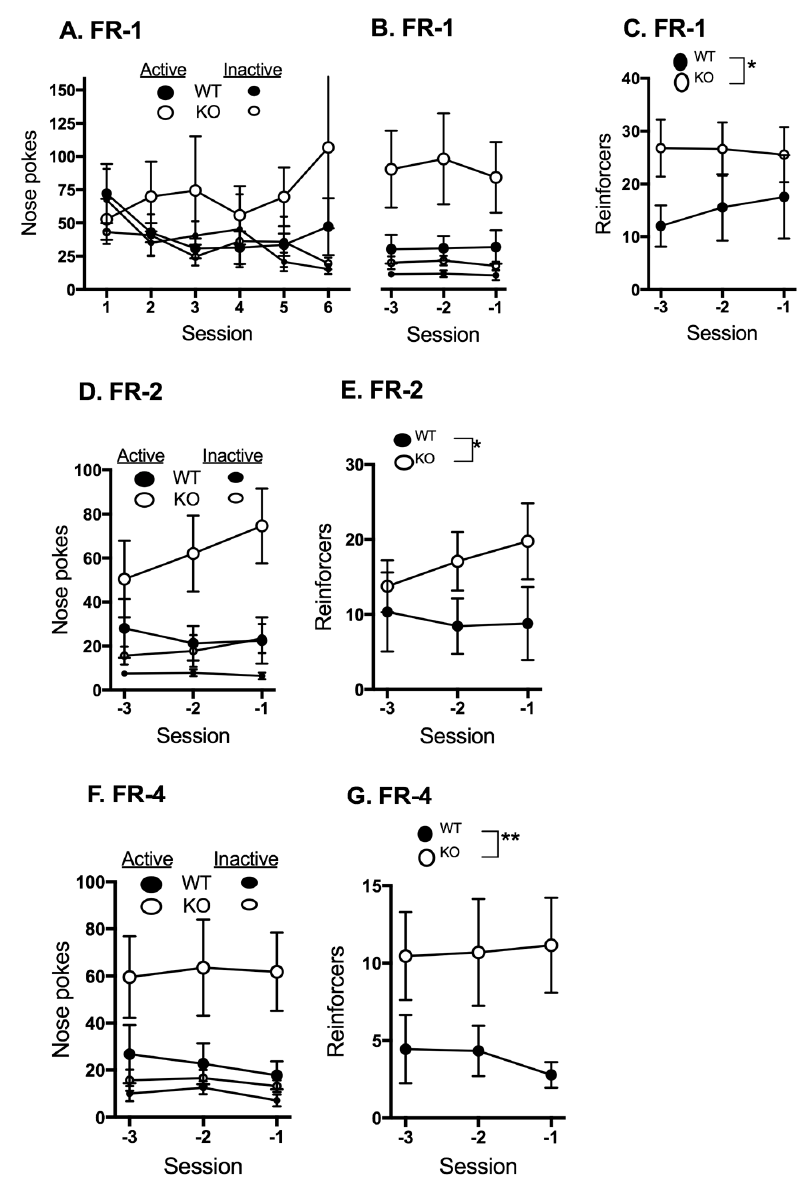
Figure 4. Comparison of WT and fatty acid amide hydrolase knock out (FAAHKO) active and inactive nose-poke responses and reinforcers earned during FR schedules. Mice (9 WT and 13 FAAHKO) were placed into operant chambers with two nose-poke ports for 2 h daily for 6 consecutive days per week. Responses in one of the nose-poke ports triggered a combination of visual and auditory responses, the other did not. Mice progressed through three FR schedules in sequence. Responses in the active port are indicated with large circles, inactive with small circles. Filled circles represent data from WT mice, open circles from FAAHKO mice. Mean values are shown; vertical lines represent SEM. Negative numbers in panels B–G denote the final three sessions prior to the session in which criteria were met for promotion of each animal to the next schedule. ( A ) Mean nose-poke responses in the active and inactive ports during the first six sessions of FR-1; ( B ) Mean nose-poke responses in the active and inactive ports during the final three sessions of FR-1; ( C ) Mean reinforcers earned during the final three sessions of FR-1; ( D ) Mean nose-poke responses in the active and inactive ports during the last three sessions of FR-2; ( E ) Mean reinforcers earned during the last three sessions of FR-2; ( F ) Mean nose-poke responses in the active and inactive ports during the last three sessions of FR-4; ( G ) Mean reinforcers earned during the last three sessions of FR-4. * p < 0.05, ** p < 0.01.